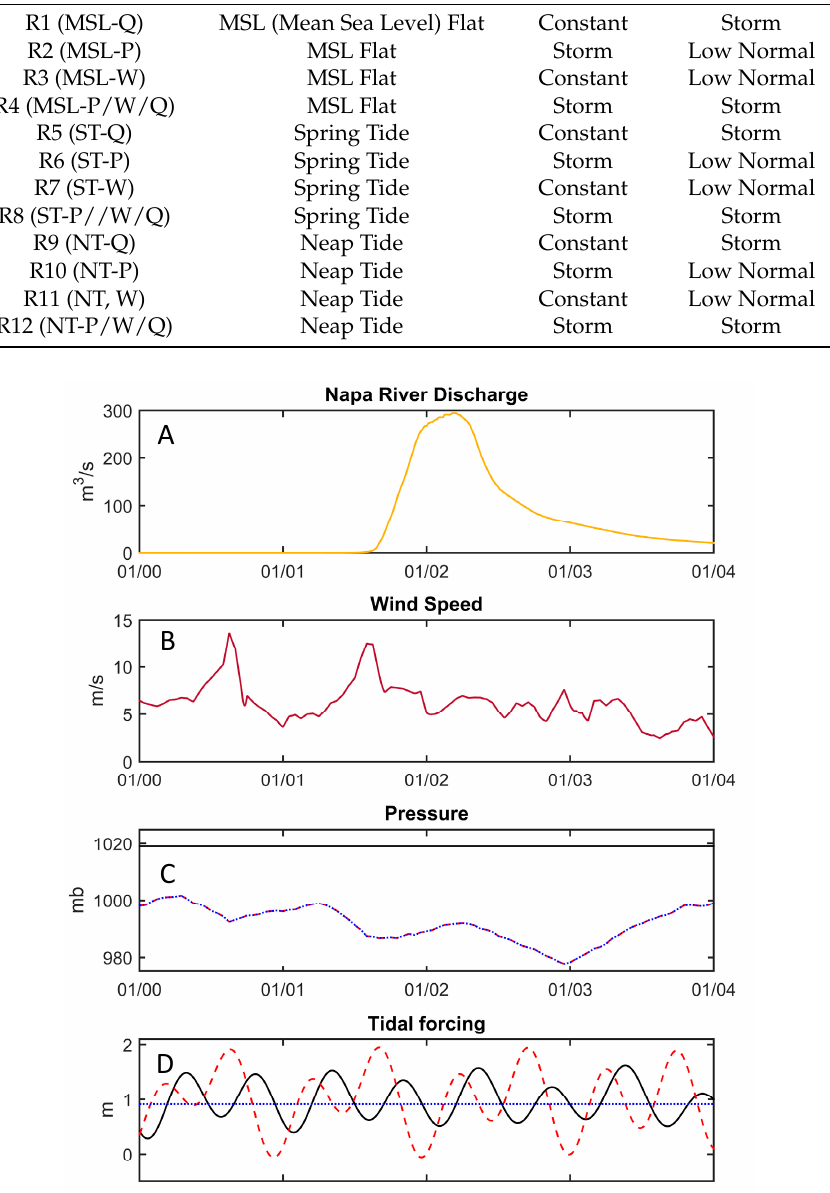
Figure 3. Realistic storm forcings. ( A ) Discharge at the head of Napa River (see Figure 1 for location). ( B ) Wind speed, ( C ) atmospheric pressure at sea level, for the storm (dashed red) and not storm case (solid black), and ( D ) water level variations due to astronomic tides at San Francisco (red dash is spring, solid black is neap, and small blue dash is water held at Mean Sea Level), see Figure 1 for location. The forcings utilized for the idealized scenarios, as shown in Table 3, were simplified versions of the real cases, see Figure 4. The atmospheric conditions were idealized with a low pressure that lasted for 2 days starting with 1 day of background pressure levels and negligible (less than 20 cm/s) winds for a smooth transition. Spring and neap tides were simplified to tides with an M2 period